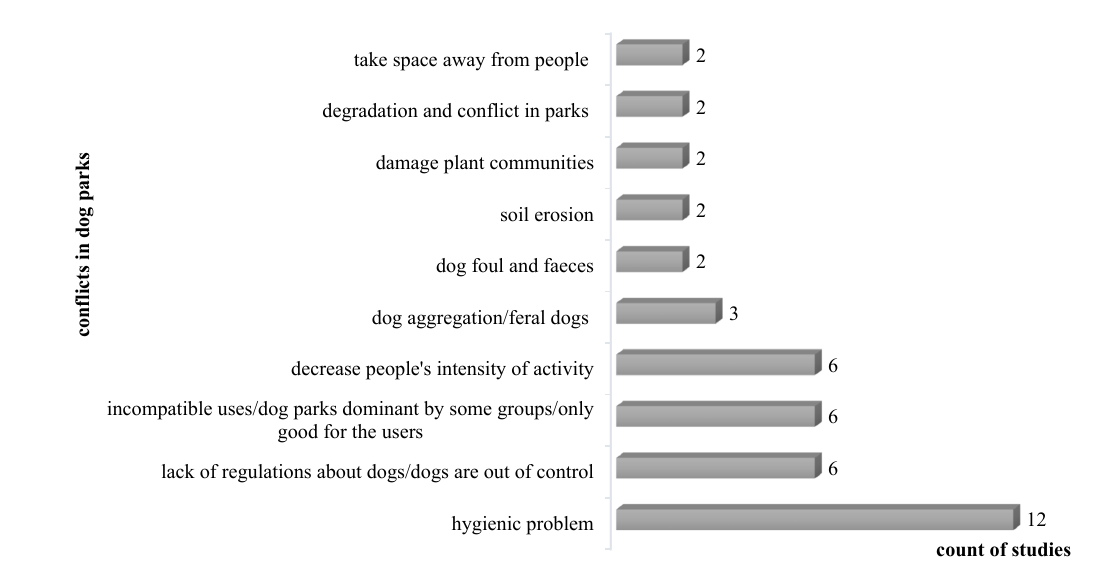
Figure 5. Count of studies identifying the conflicts occurring in dog parks.